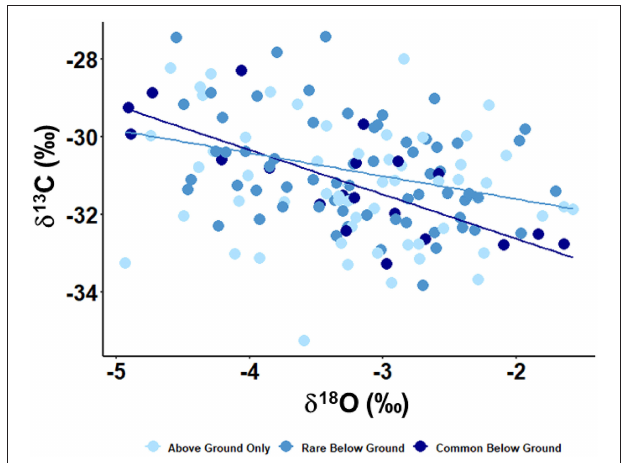
FIGURE 2 | Leaf δ 13 C by stem water δ 18 O and the relationships among rooting habit groups. The linear regression for the above ground only group (light blue) was not significant ( R 2 = 0.02, p = 0.13), while the regressions for the rare below ground (medium blue) and common below ground (dark blue) groups were significant ( R 2 = 0.09, p < 0.01 and R 2 = 0.55, p < 0.01, respectively).